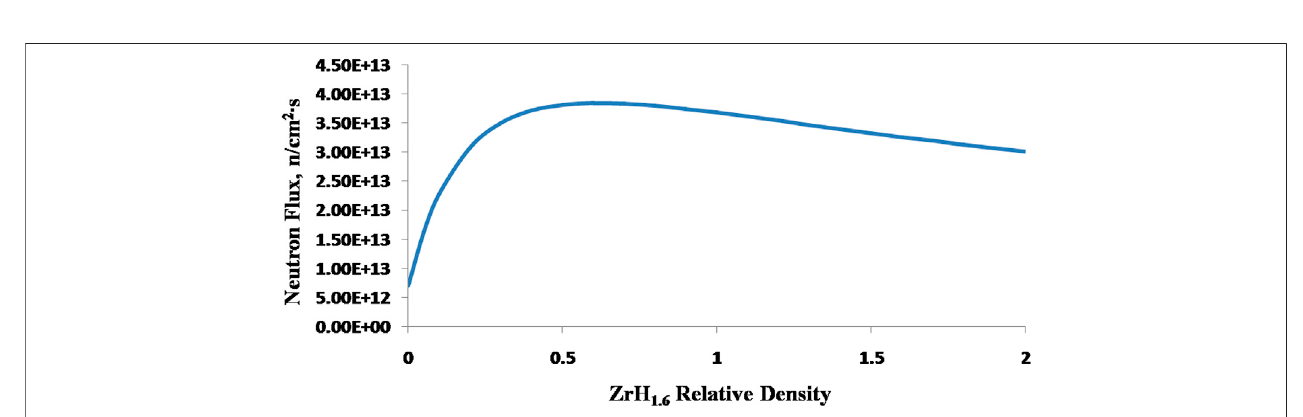
FIGURE 6 | Neutron fl ux versus ZrH 1.6 relative density (0.01 eV – 10 4 eV).